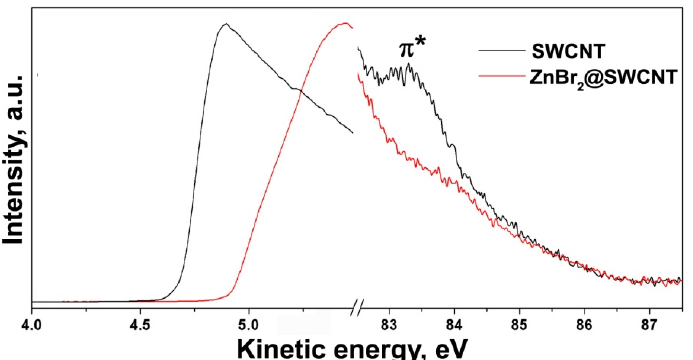
Figure 7. The valence band and secondary electrons cutoff spectra of the pristine SWCNTs and nanotubes filled with zinc bromide. Reprinted by permission from [14]: SpringerNature, European Physical Journal B, Kharlamova et al. Acceptor doping of single-walled carbon nanotubes by encapsulation of zinc halogenides, copyright 2012.